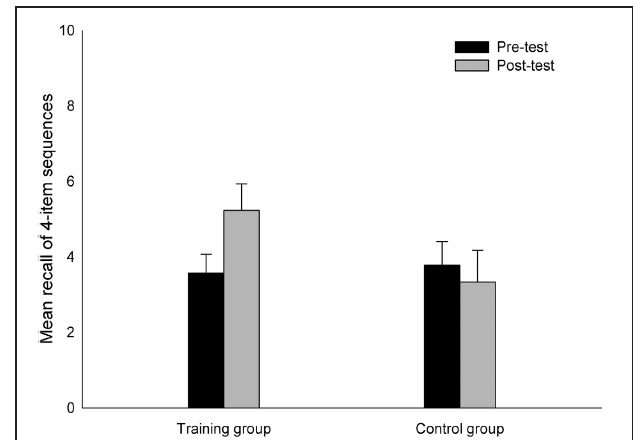
FIGURE 2 | Improvement in the performance of the training group through the training period and the performance of the control group in the pre- and post-tests in the dual n -back task. For each session, the mean n -back level is presented. Error bars indicate standard errors of the mean.